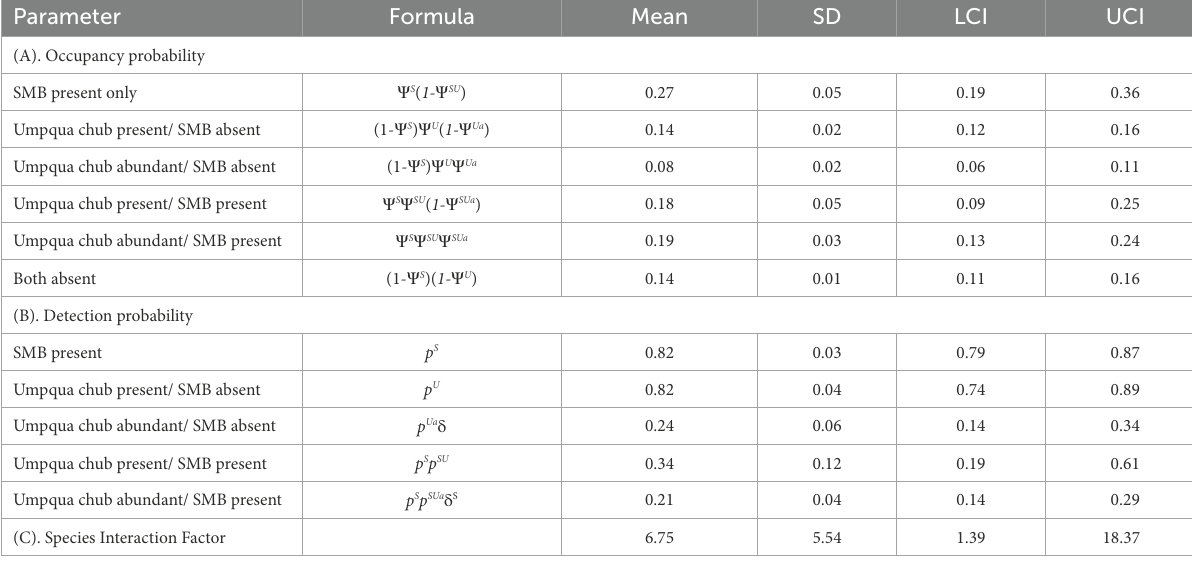
TABLE 4 Parameter estimates for (A) mean occupancy probability for each state, (B) probability of detecting the true state, and (C) species interaction factor with standard deviation (SD), and lower (LCI) and upper (UCI) 95% credible intervals from best approximating Umpqua chub/ smallmouth bass (SMB) 2SMS model from the Umpqua basin, Oregon, United States. Parameter Formula